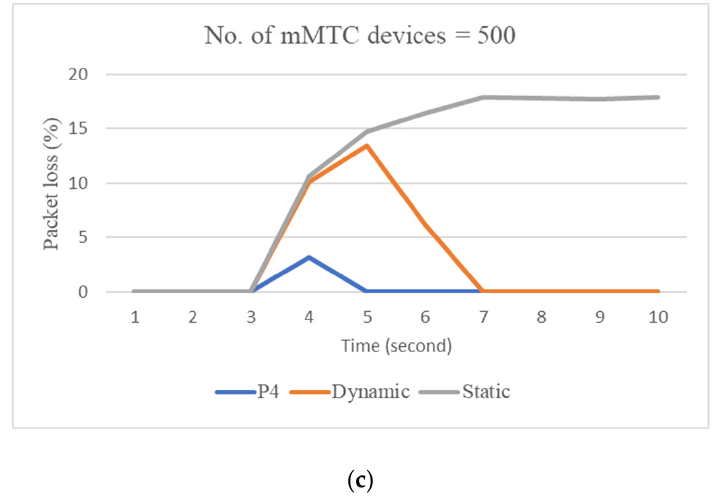
Figure 11. Average packet loss ratio versus time in the URLLC slice for ( a ) 100; ( b ) 250; ( c ) 500 mMTC devices.